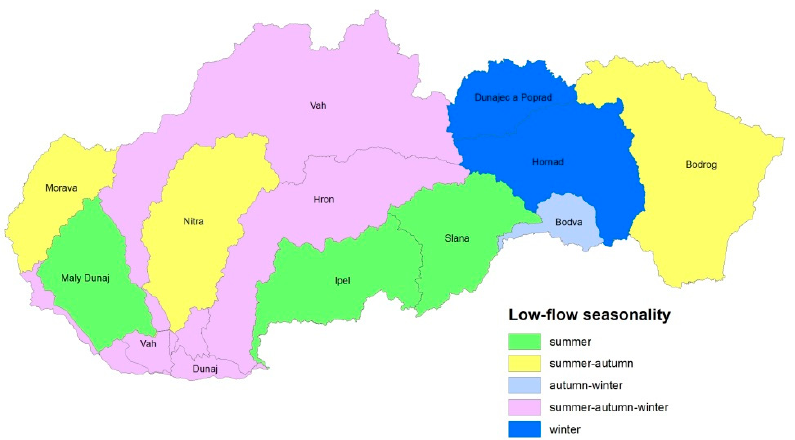
Figure 12. Sub-catchments in Slovakia according to the prevailing seasonality of the five longest low-flow episodes; 1961–2015, limit Q 364d .